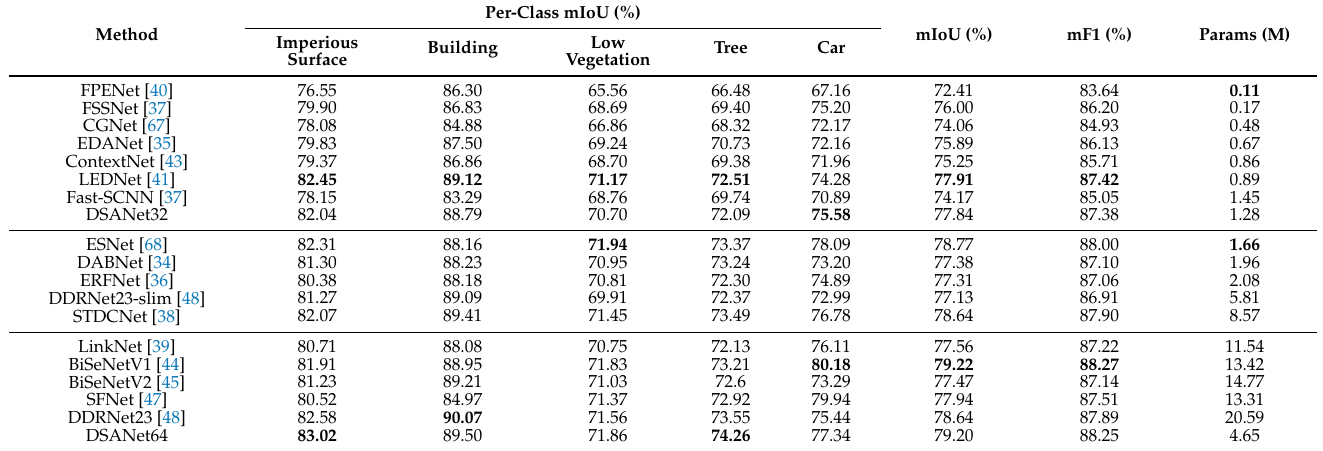
Table 8. Comparison of DSANet with the State-of-the-Art Models on the Potsdam Dataset.